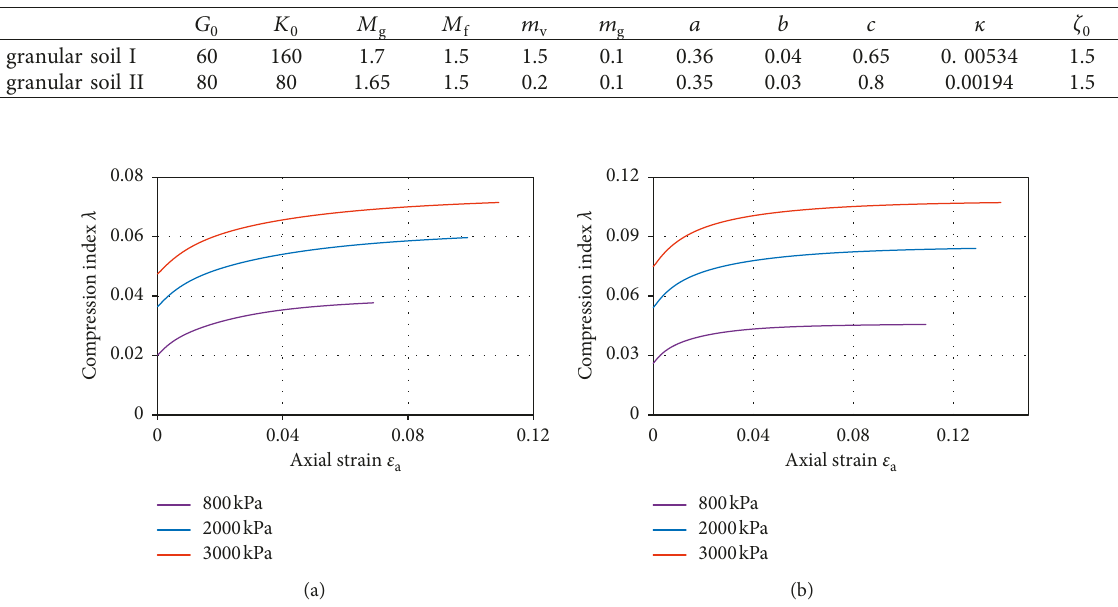
Table 2: Parameters of the enhanced model for coarse granular soils I and